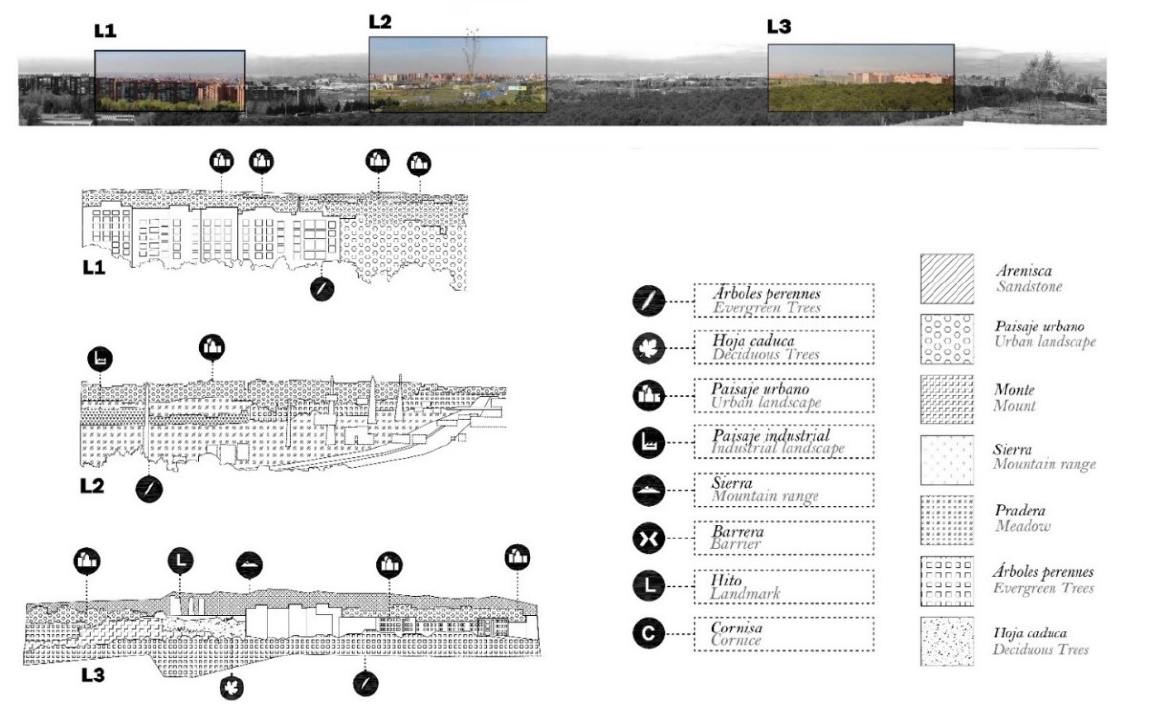
Figure 9: Panorama, selected frames and interpretive drawings from ‘TíoPío’